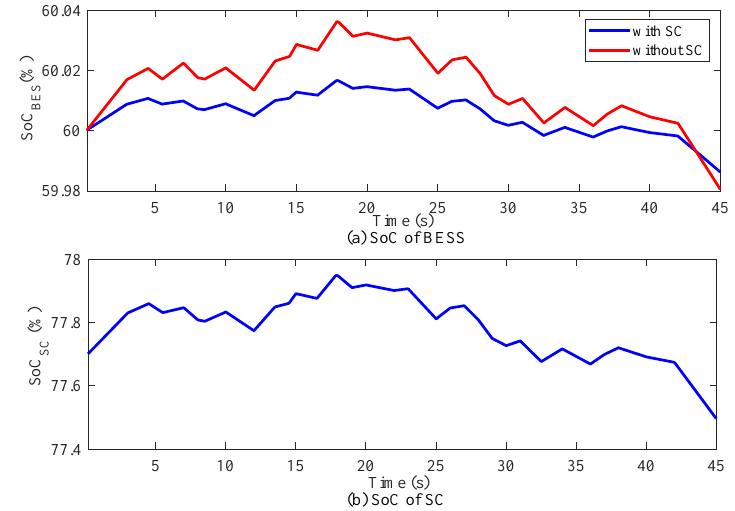
Figure 11. State of charge (SoC) responses for both BESS and SC under surplus and deficit power modes considering more fluctuations in the solar